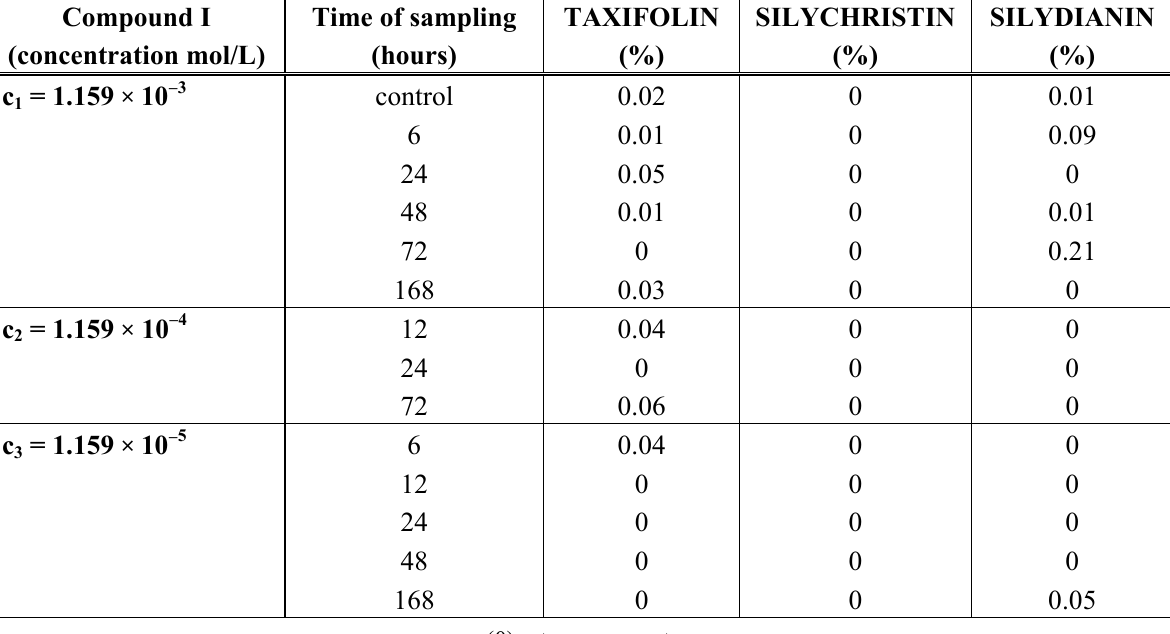
Table 3. Content of taxifolin, silychristin and silydianin (%) in 100 mL of suspension culture nutrient